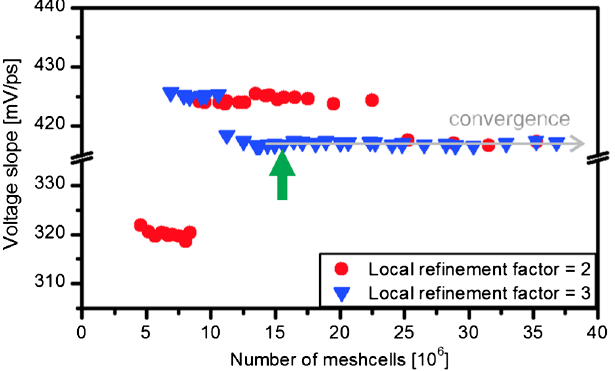
FIG. 2. Plot of the slope vs the number of mesh cells and two settings of the local mesh refinement. Two symmetry planes are used for the simulation such that only one quarter of the model has to be considered. The slope converges to approximately 417 mV = ps